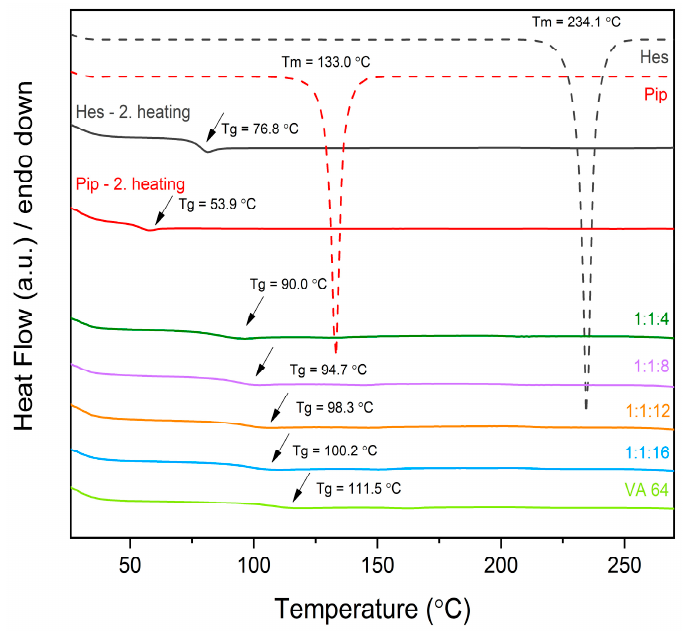
Figure 2. Thermograms of raw compounds and amorphous systems. Amorphous systems were named as a mass ratio of individual components, Hes:Pip:VA 64 (Hes: hesperetin, Pip: piperine, and VA 64: PVP VA 64).